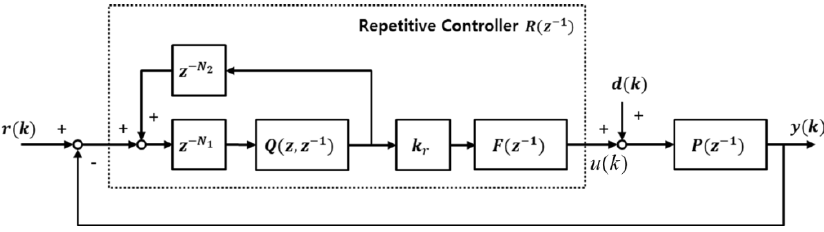
Figure 6. Repetitive control system with a low-pass filter in the discrete-time domain.